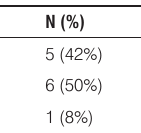
Table 1. Localization of Brenner Tumors.